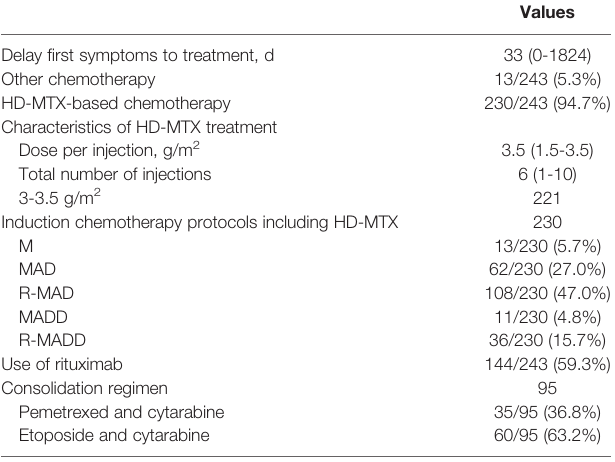
TABLE 2 | Treatment